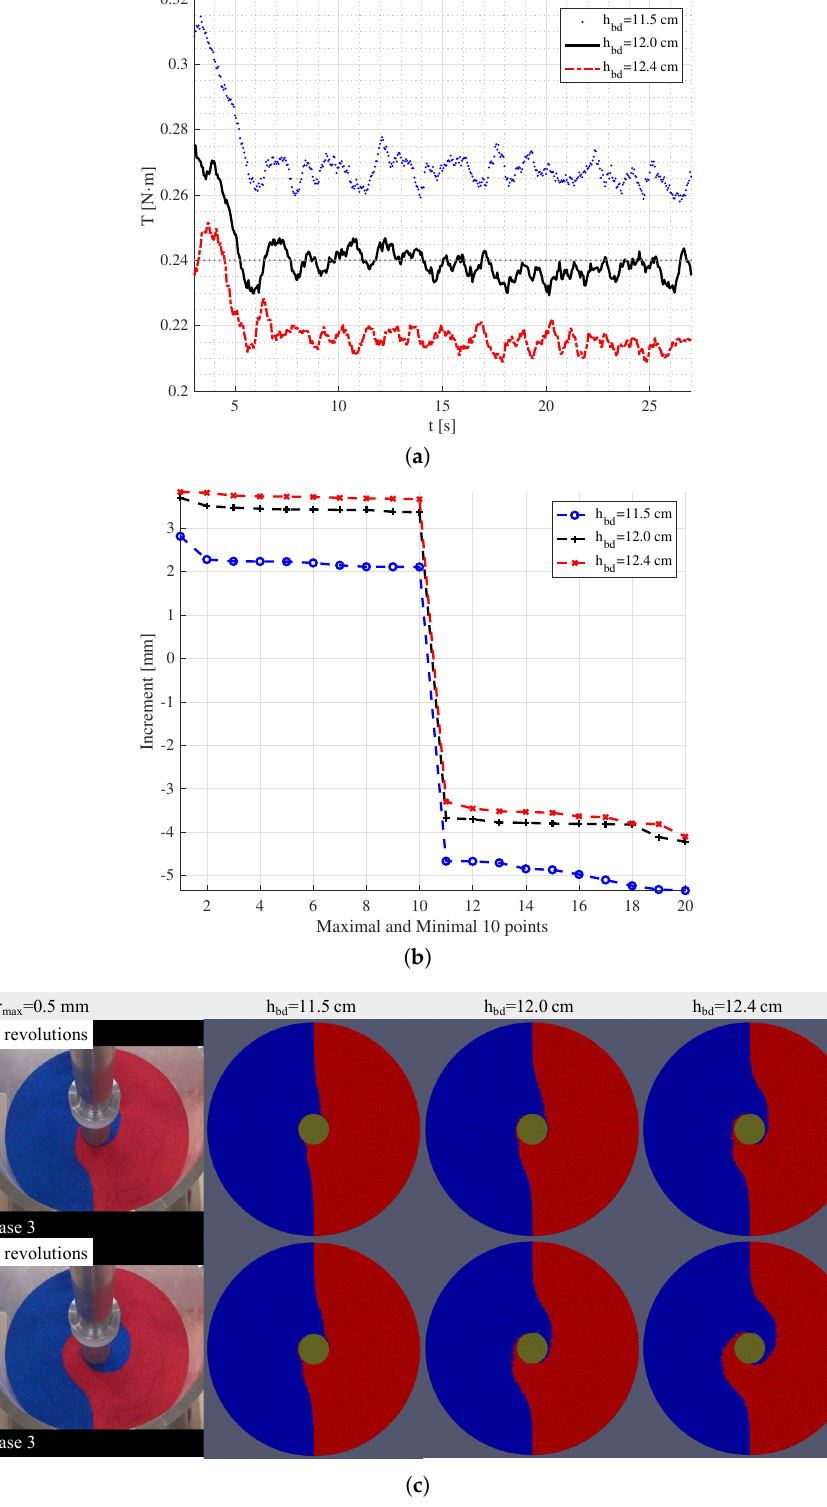
Figure 11. Influence of blade position: the torques ( a ), increase of height ( b ) and mixing patterns ( c ) for Case 3 with three different blade heights h bd with respect to the tip of the mixer